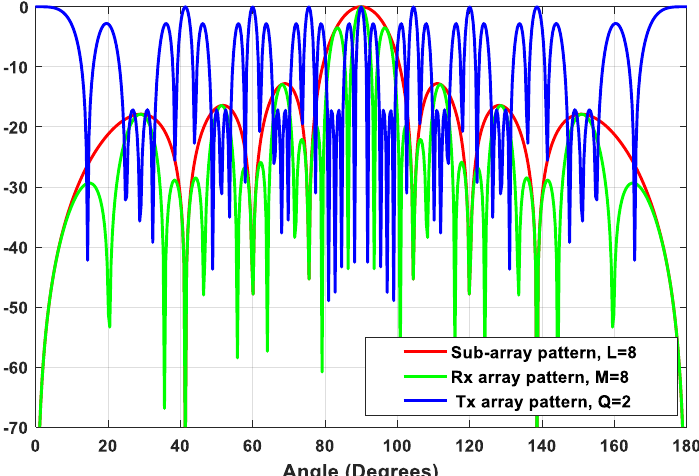
Figure 5. The arrays patterns of the receiver array, transmitter array, and the subarray for M = 8,